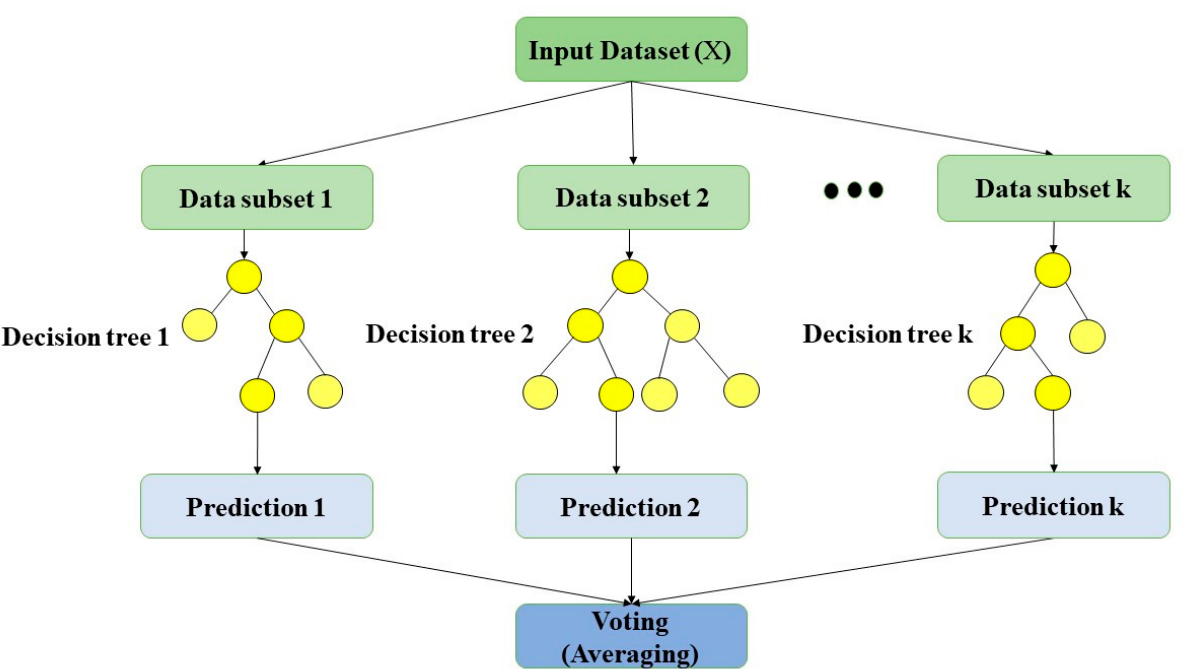
Figure 3. Architecture of RF .